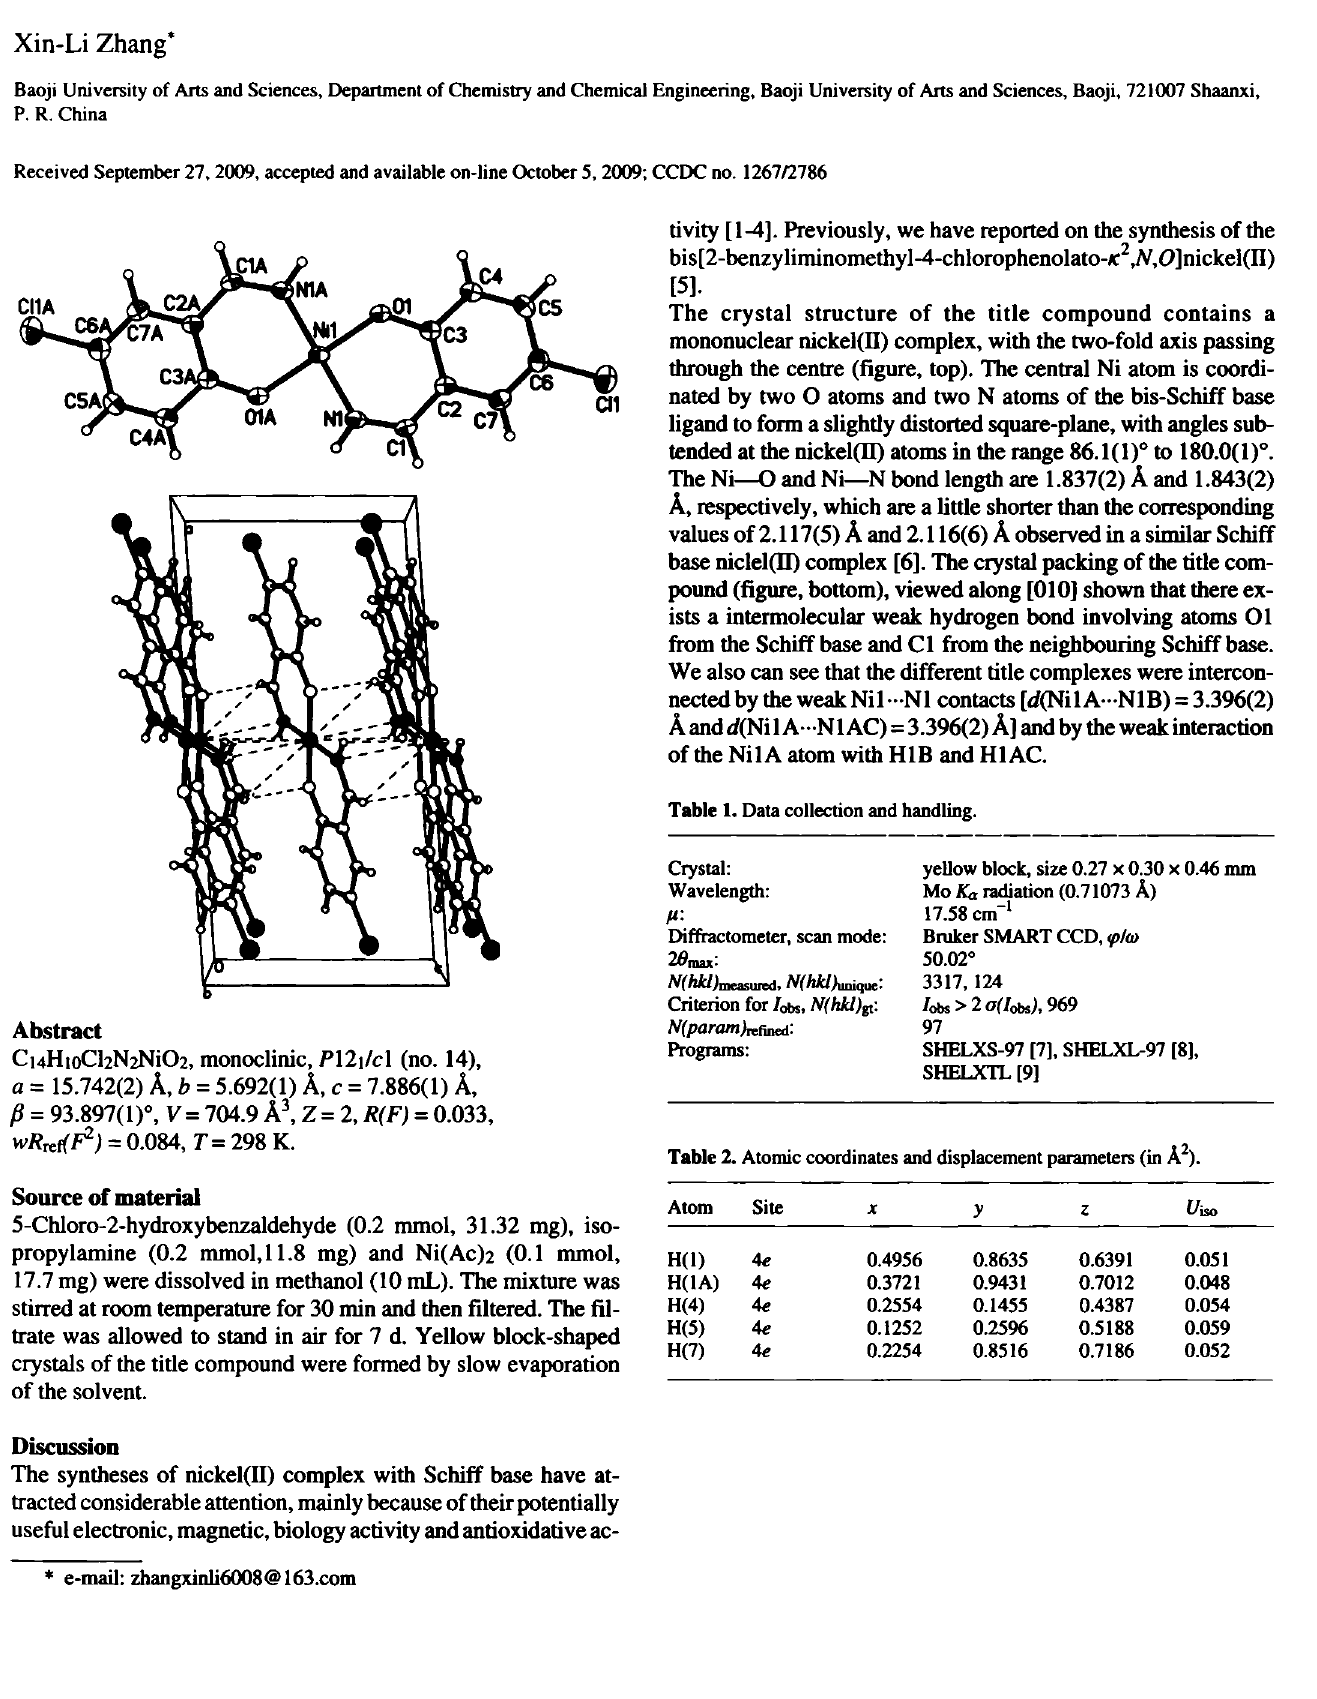
Table 2. Atomic coordinates and displacement parameters (in Â 2